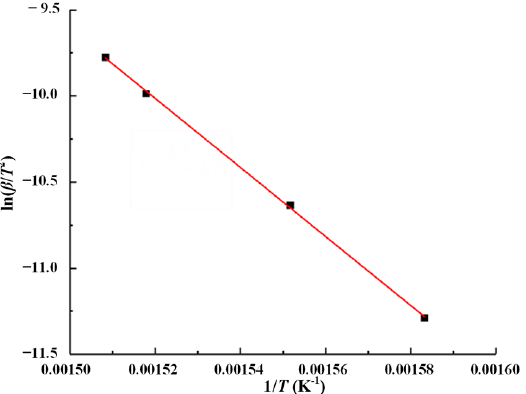
Figure 4. Results at different conversion rates based on the Flynn–Wall–Ozawa method: ( a ) linear fitting curves; ( b ) activation energy results.